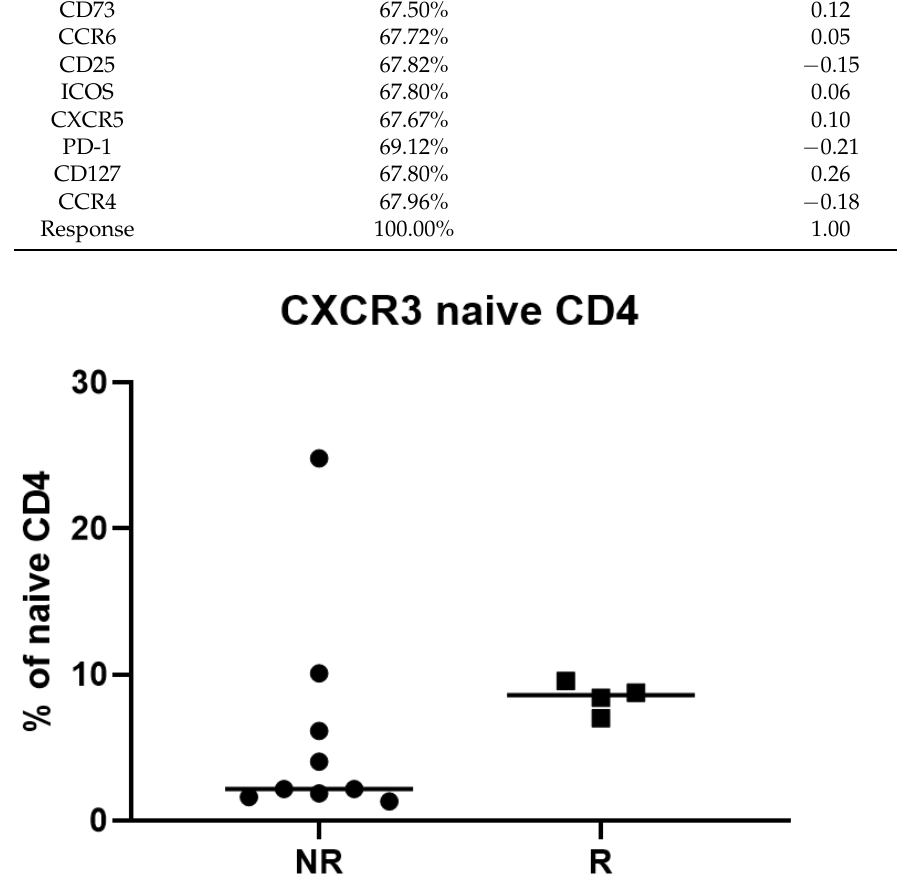
Figure 8. “Traditional” flow cytometry assessment of CXCR3 expression. Naïve CD45RA+ CD4+ CD3+ T cells were manually gated using FlowJo flow cytometry analysis software. The fraction (%) of naïve CD4+ T cells manually judged to express CXCR3 across patient responders (R) and nonresponders (NR) are shown. Unpaired two-tailed t-test resulted in p -value of 0.5496, indicating no significant difference between responders and nonresponders.